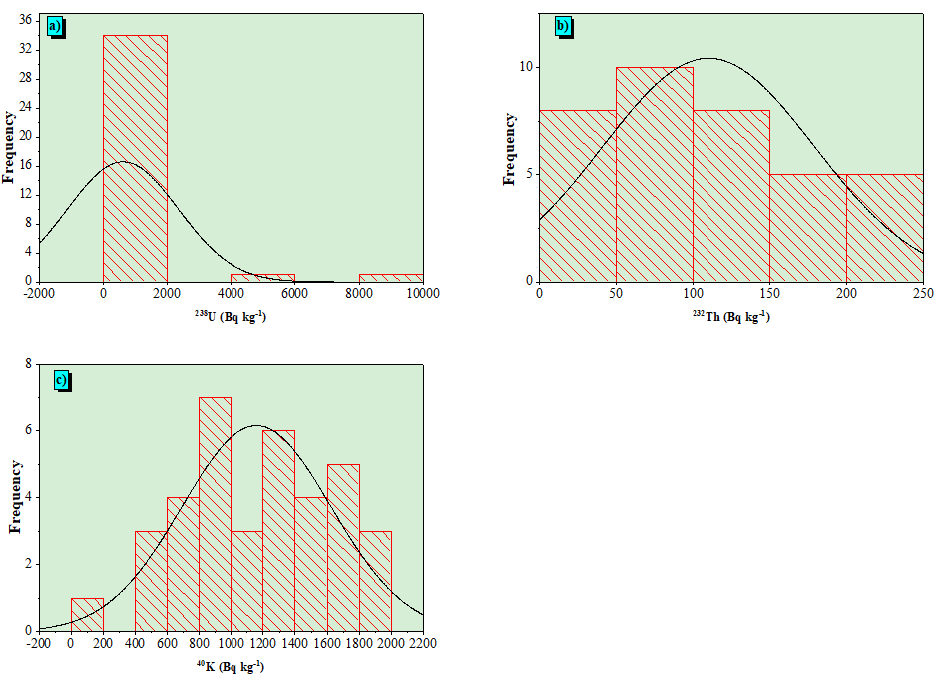
Figure 9. The frequency distribution of: ( a ) 238 U activity concentration, ( b ) 232 Th activity concentra- tion, and ( c ) 40 K activity concentration in the GR in the studied area. Table 4. Results of normality tests. Table 3. Descriptive statistics of 238 U, 232 Th, and 40 K activity concentrations of the studied granitic rock.